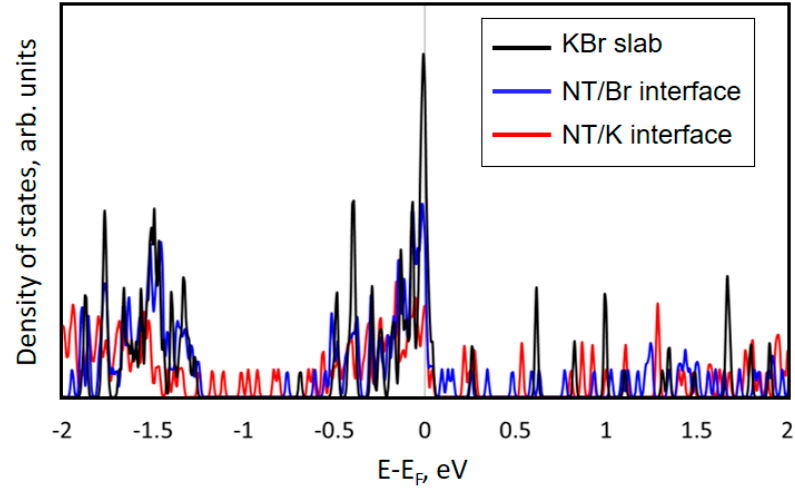
Figure 7. The density of the electronic states for all considered interfaces.